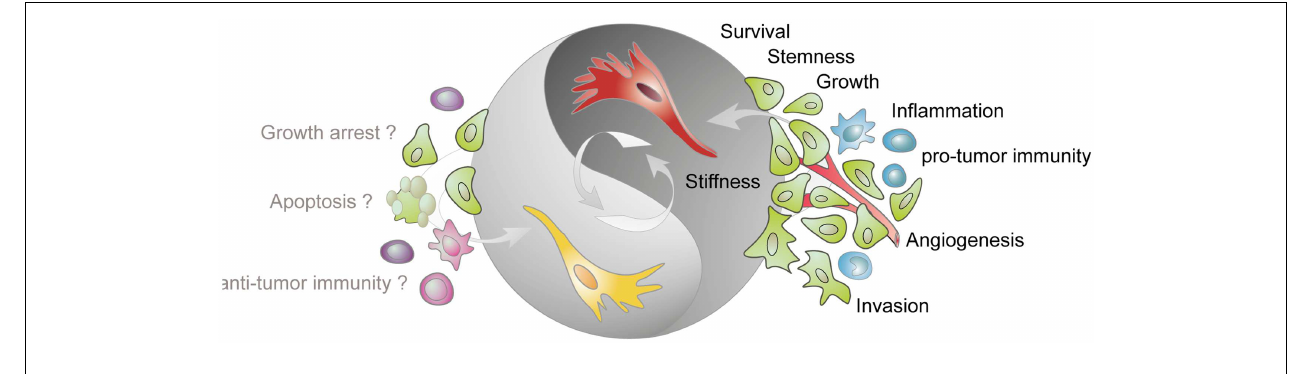
milieu, and impact on the activation state of various immune cells. More recent data demonstrate that tumor-resident fibroblast (depicted in yellow) can also confer tumor-suppressive effects. However, the mechanisms underlying this inhibitory phenotype are not known but may involve direct inhibition of cancer cells and modulation of immune cell